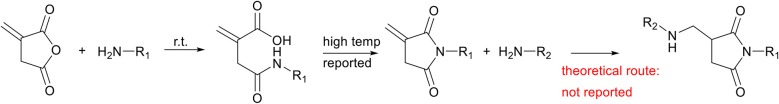
Schematic overview of the reaction of itaconic anhydride with a primary amine (left), which after thermal treatment yields itaconimides (middle right), with the unsaturation still present. Although several Michael addition reactions on this double bond have been described, to date no aza-Michael addition reaction has been described on itaconimides (right).